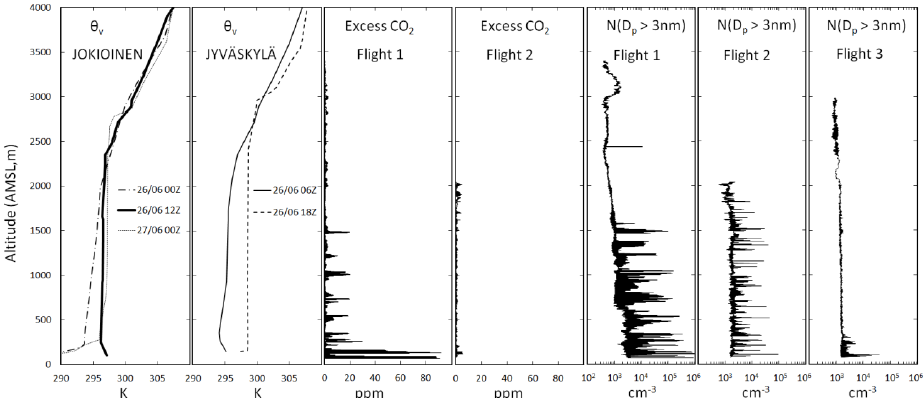
Fig. 13. Vertical profiles of virtual potential temperature ( θ v ), excess CO 2 and total particle number concentrations during the experiment day. For flight 3, no excess CO 2 data are shown because they did not deviate from zero. The θ v data are from meteorological soundings from two sites, the Jokioinen Observatory and the Tikkakoski Airport in